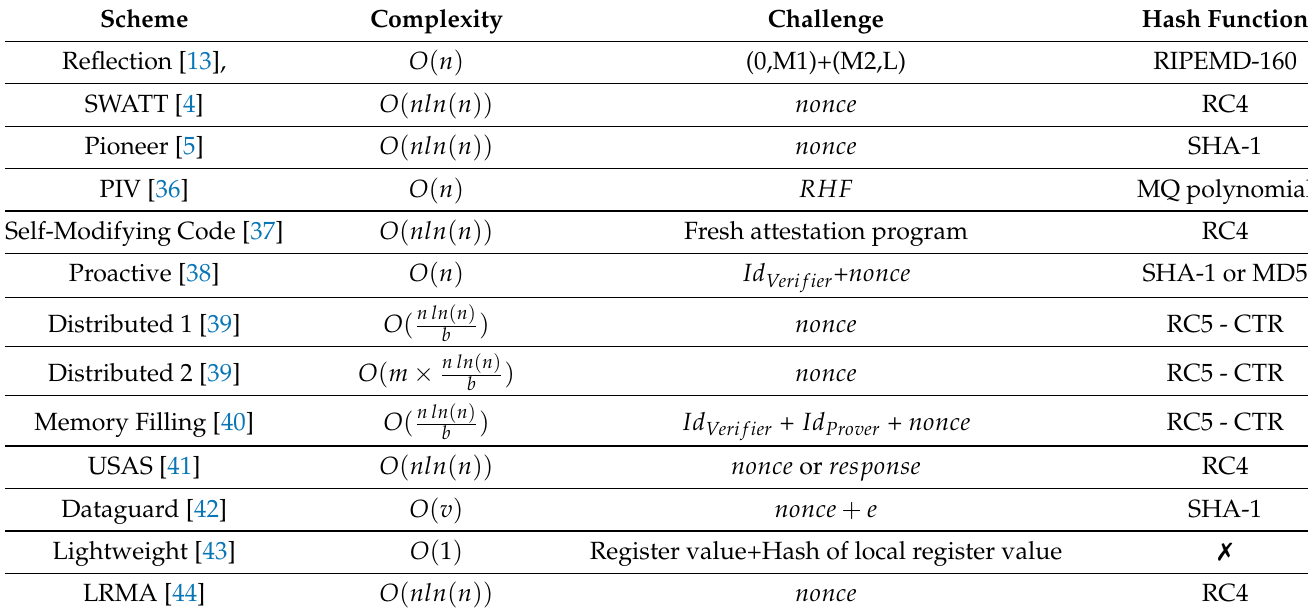
Table 3. Summary of software-based RA